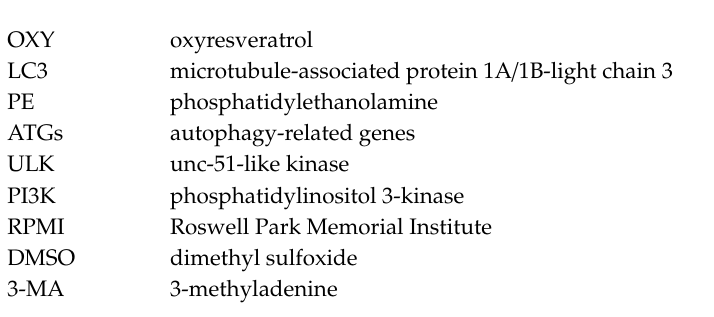
Figure S1: Western blot data. The full-length blots of Figure 2A. Figure S2: Western blot data. The full-length blots of Figure 3C. Figure S3: Western blot data. The full-length blots of Figure 6B. Figure S4: Western blot data. The full-length blots of Figure 6D. Figure S5: Western blot data. The full-length blots of Figure 7C. Figure S6: Western blot data. The full-length blots of Figure